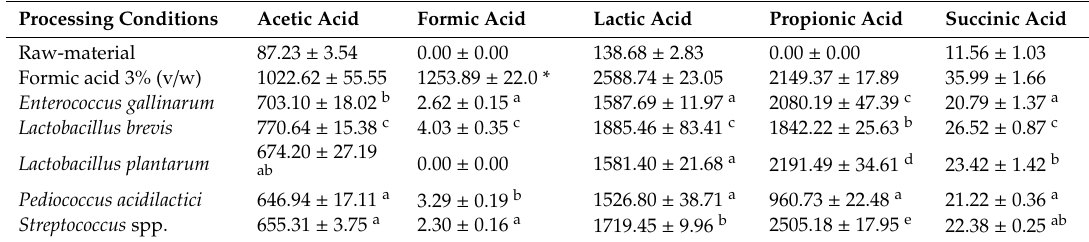
Table 6. Yields (mean value ± standard deviation, expressed in mg organic acid / 100 g sample ) ( n = 3) of organic acids in acidified and fermented wet fish processing by-product silages of 3 weeks. In the fish silages, the acidic conditions were obtained by adding formic acid 3% (v / w), whereas the fermentation were carried out by independent inoculations with pure cultures of distinct lactic acid bacteria